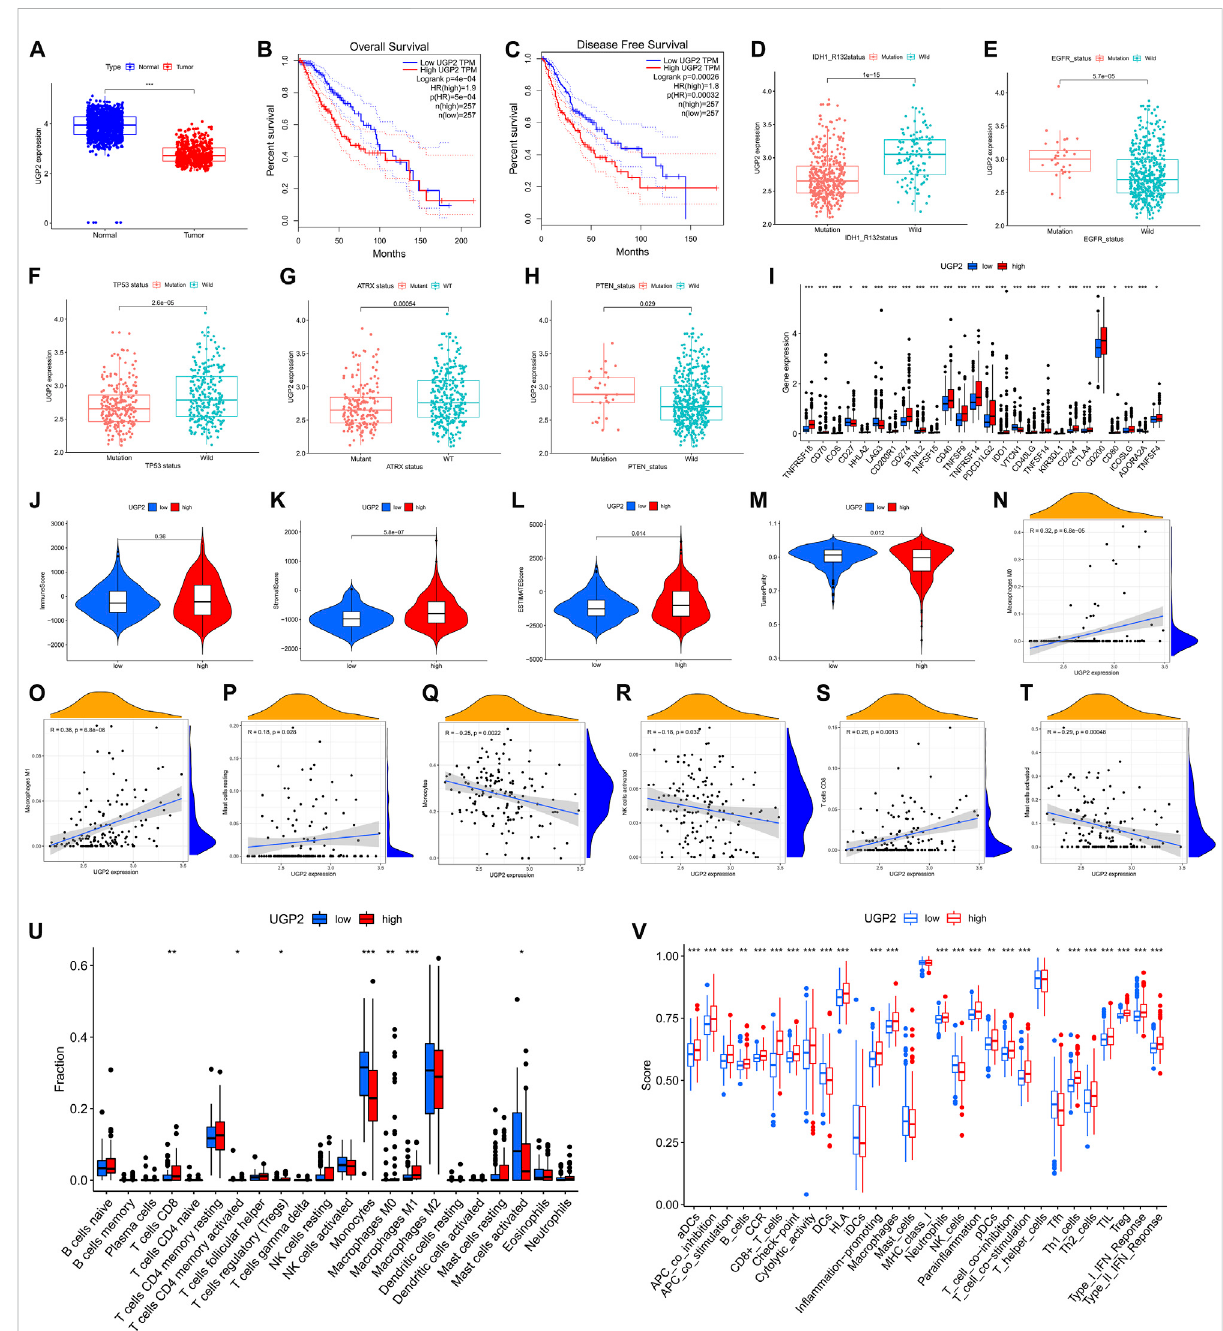
FIGURE 11 The clinicopathological value of UGP2 in LGG and TME features. (A) . UGP2 expressed in LGG tumor tissue and normal tissue. Lower UGP2 expression led to prolonged overall survival (B) and disease-free survival (C) . (D – H) . The UGP2 expression exhibited substantial differences among the mutation status of IDH1 ( R132 ), EGFR , TP53 , ATRX , and PTEN . (I) . The expressions of immune checkpoint blockade-related genes between the low- and high- UGP2 subgroups. (J – M) . Comparison of ImmuneScore, StromalScore, ESTIMATEScore, and TumorPurity among low-/high- UGP2 groups. (N – T) . Relationship between low-/high- UGP2 groups with activated mast cells, activated NK cells, monocytes, CD8 + T cells, resting mastcells,aswellasM0andM1macrophages. (U) .ComparisonofCIBERSORTresultsbetweenlow-/high- UGP2 groups. (V) .ComparisonofssGSEA enrichment between low-/high- UGP2